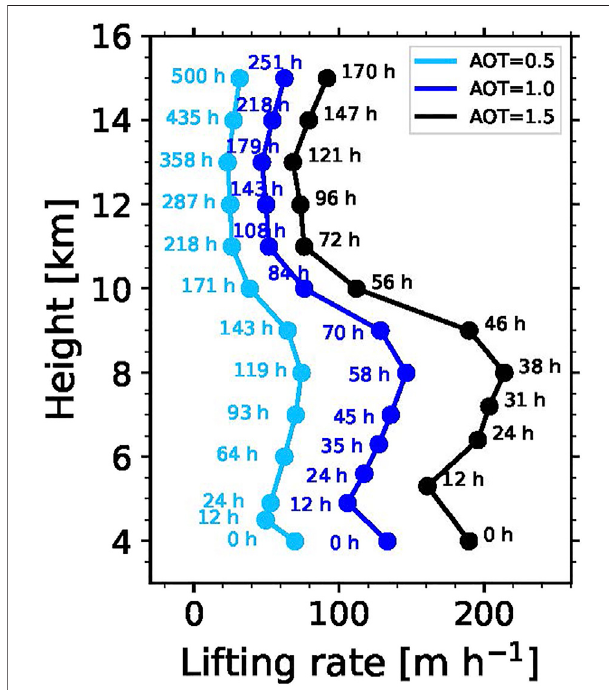
FIGURE 10 | Simulation of self-lifting of Siberian wild fi re smoke (injected to 3 – 5 km height). The 532 nm AOT of the 2-km thick smoke layer, initially centered at 4 km height, was assumed to be 0.5, 1.0, and 1.5. Cloudfree conditions are simulated. Smoke was able to reach heights of 10 km within about 2 – 7 days (indicated by the hours after ascent start) according to these simulations. Even under stable stratopsheric conditions further slow ascent by smoke is